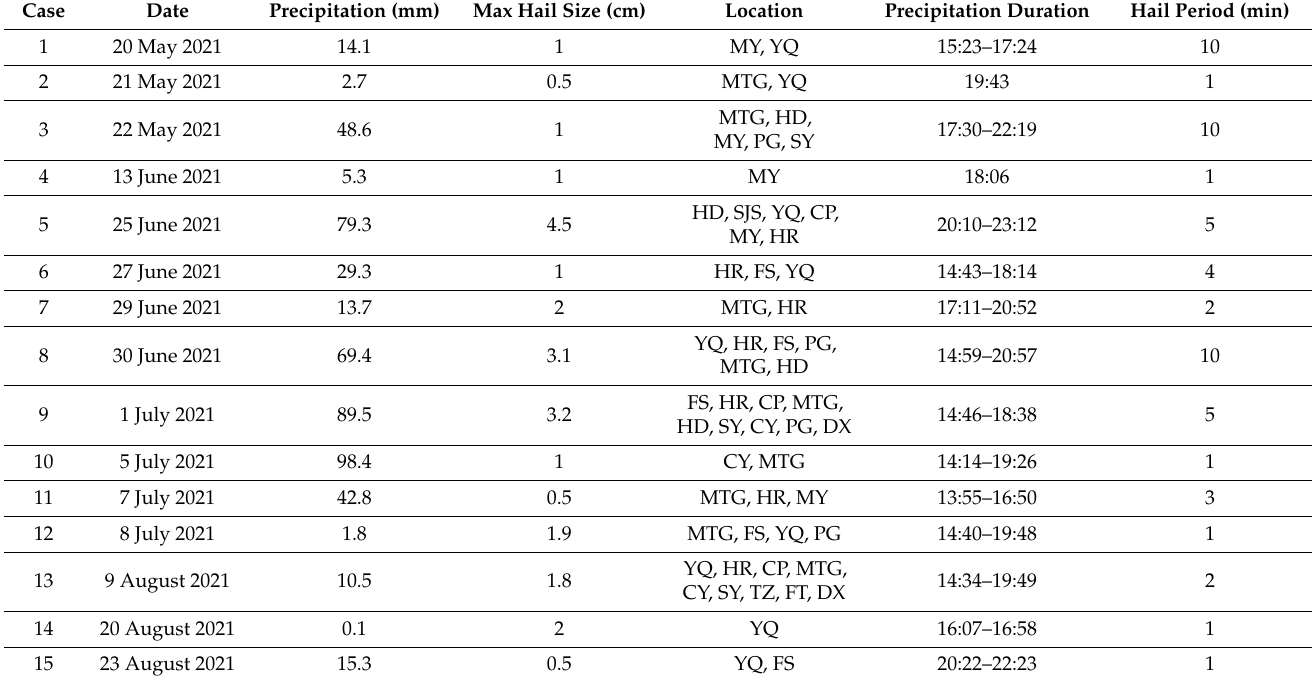
Table 1. Hailstorm information from May to August 2021 in Beijing.